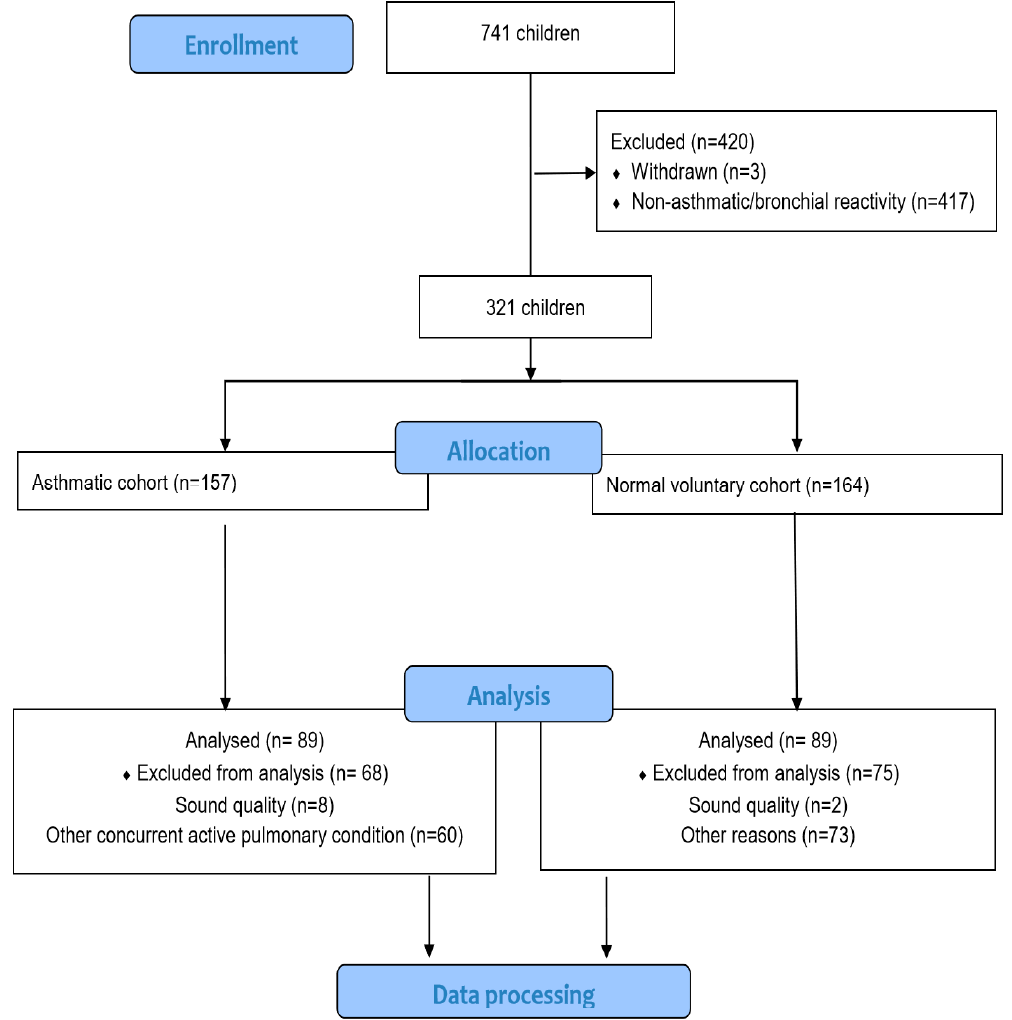
Figure 2. Subject recruitment, enrolment, cohort creation, and data processing flow diagram.